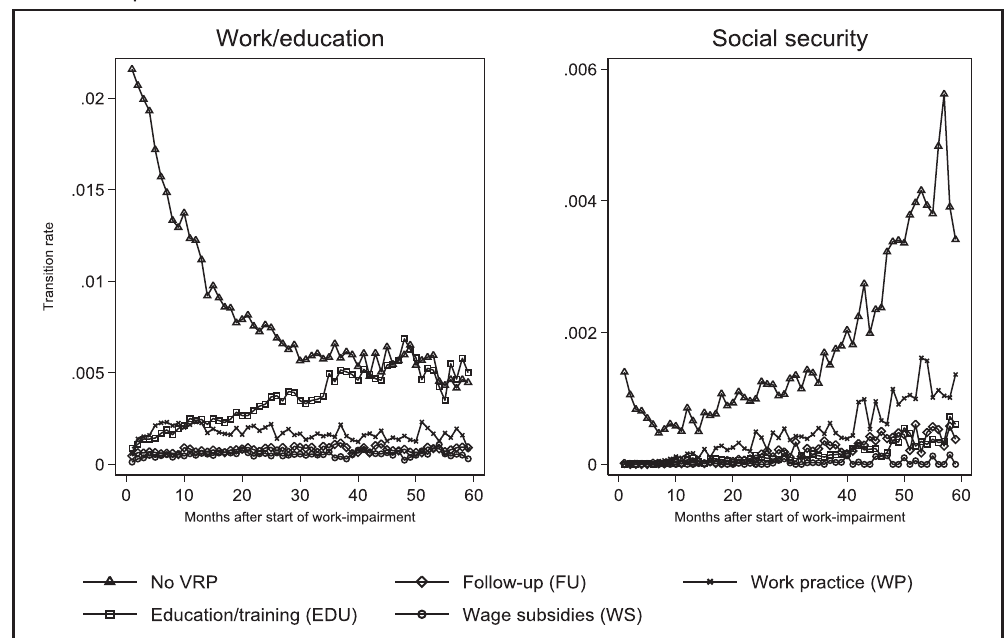
Monthly transition into work/education and social security, by vocational rehabilitation program (VRP) status. Young people 18-29 years of age during the period